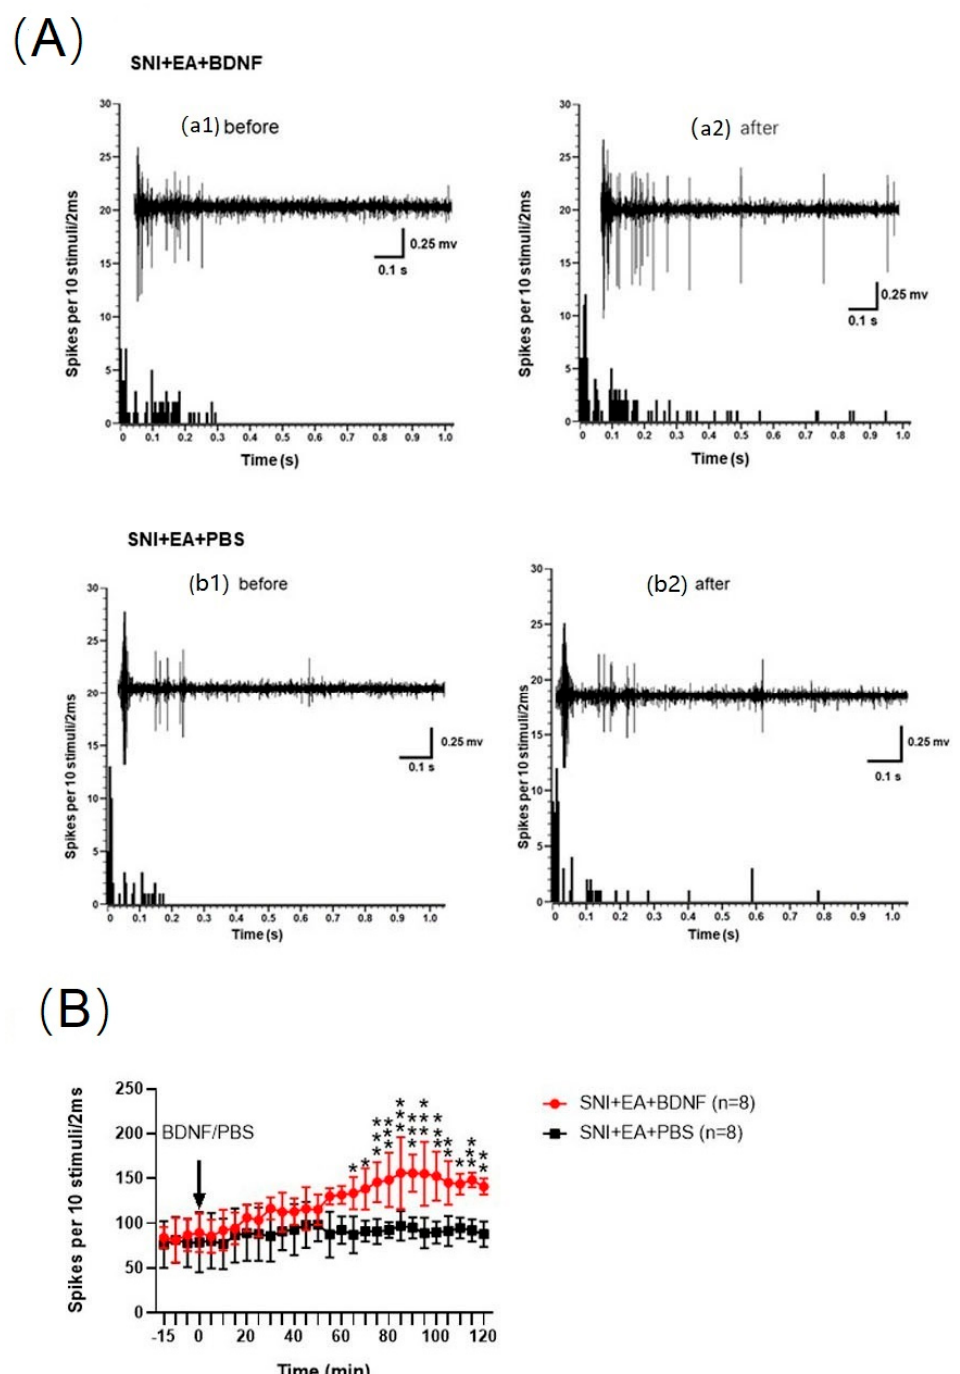
Figure 7. Effects of spinal administration of BDNF on the C-fiber responses of dorsal horn WDR neurons induced by 2 Hz EA treatment. ( A ) The alterations of C-fiber-evoked discharges of a WDR neuron induced by 2 Hz EA before and after administration of PBS or 100 ng BDNF. a1: 15 min after or before PBS administration (baseline); a2: 120 min after PBS administration; b1: 15 min after or before BDNF administration (baseline); b2: 120 min after BDNF administration. ( B ) The total spikes count